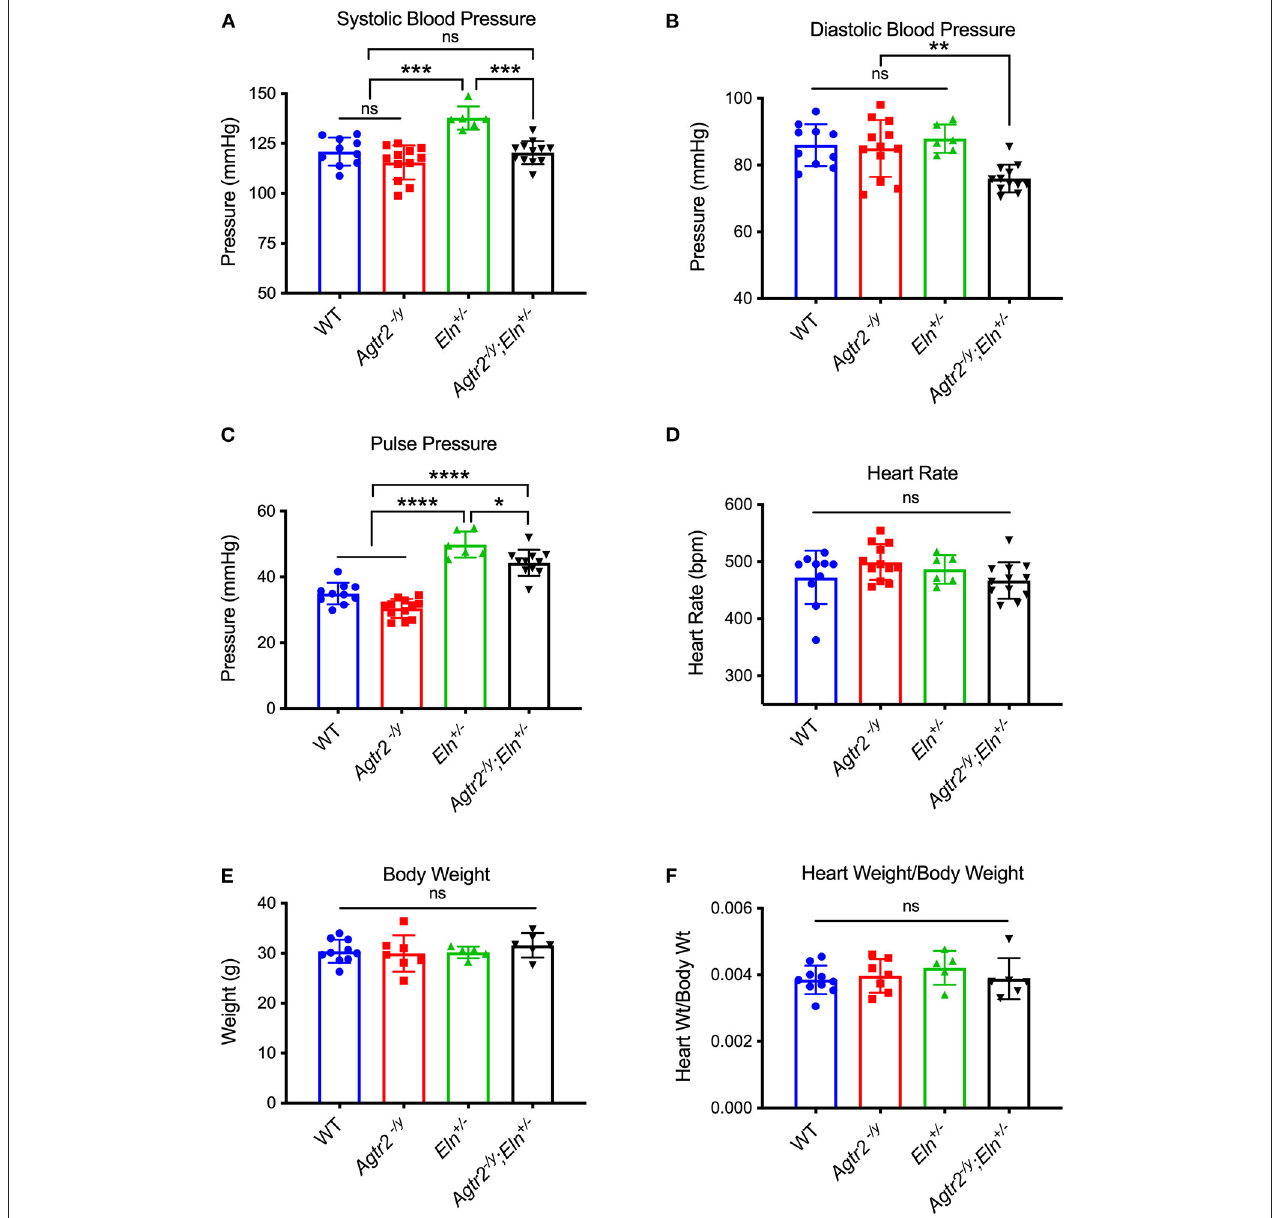
FIGURE 1 | Loss of AT2R leads to a reduction in systolic and diastolic blood pressure in elastin insufficient mice. Systolic (A) , diastolic (B) , and pulse pressure (C) [calculated as systolic–diastolic blood pressure], heart rate (D) , body weight (E) and heart weight/body weight (F) of WT, Agtr2 − / Y , Eln + / − and Agtr2 − / Y ;Eln + / − mice. Data are presented as mean ± standard deviation. One-way analysis of variance with Tukey’s multiple comparison test was performed to compare all groups. Significant difference: * P < 0.05, ** P < 0.005, *** P < 0.001, and **** P < 0.0001, between indicated